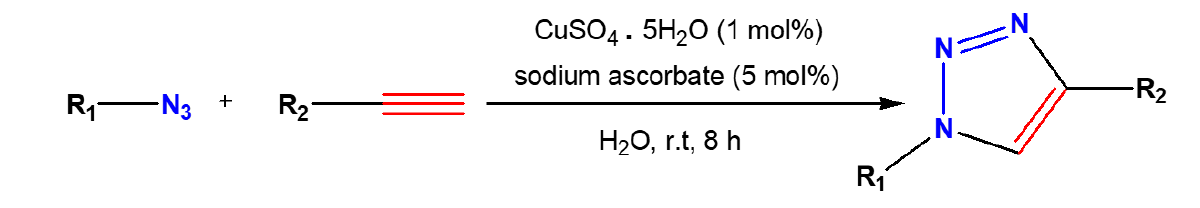
Figure 5. Azide-alkyne cycloaddition reaction mediated by copper(II) sulfate in the presence of sodium ascorbate in water at room temperature.